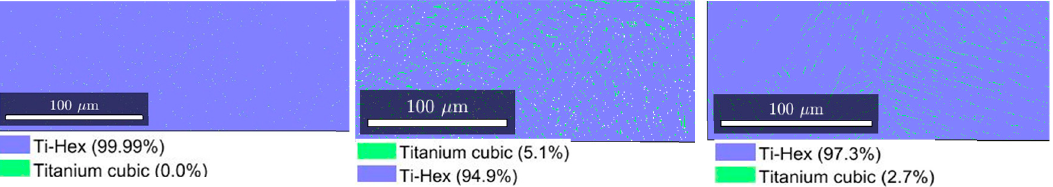
Figure 5. The EBSD phase maps showing the typical α and β -phase distributions and percentage fraction in ( a ) samples A, ( b ) samples B, and ( c ) samples C.